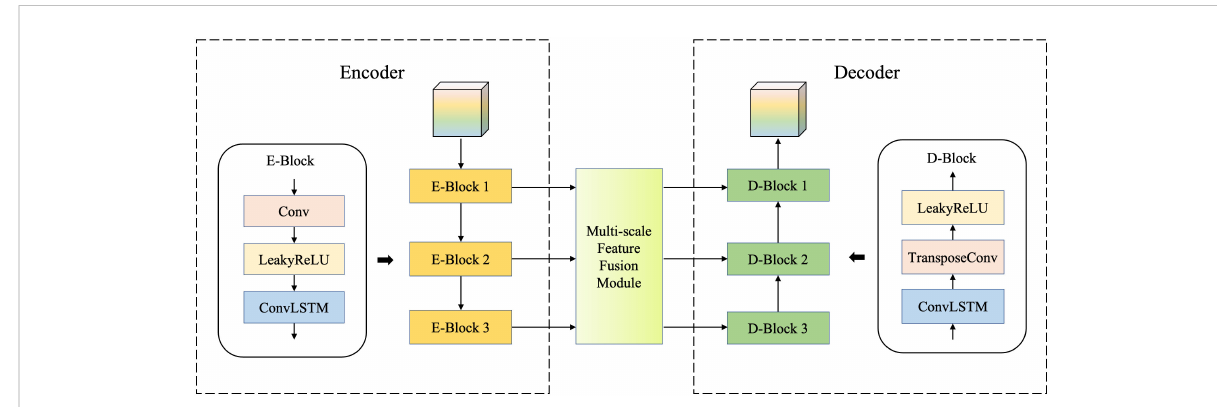
FIGURE 5 Encode – decode module. The symmetric basic model comprises convolutional layers and ConvLSTM layers. A multi-scale feature fusion module is added between the encoder and the decoder.